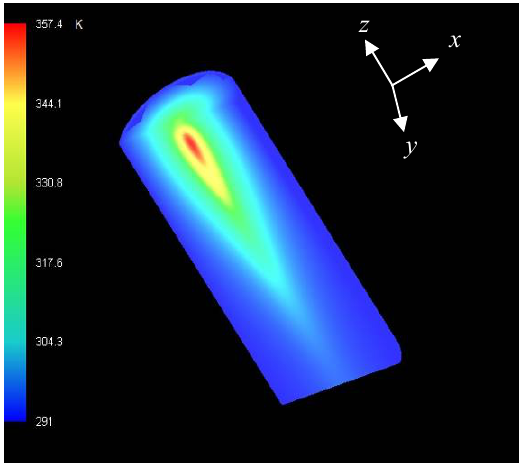
Fig. 1 Simulated temperature distribution in end pumped Nd: YLF rod of 4 mm diameter and 10 mm in length, pumped at 30